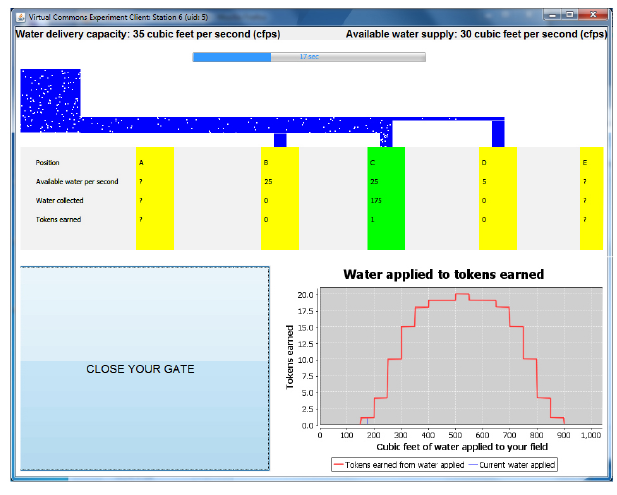
Fig. 6 . The irrigation game simulates a linear irrigation canal with five